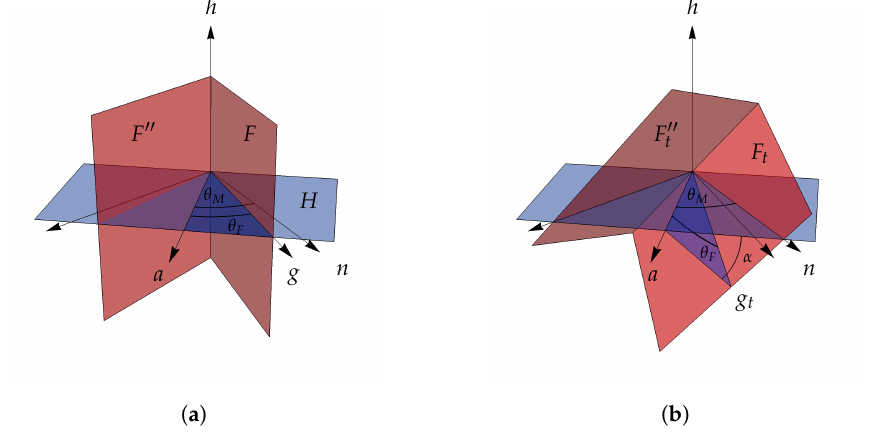
Figure 6. Further illustration of the twist transformation, in the: ( a ) initial; and ( b ) final states. Bivectors F and F (cid:48)(cid:48) with a dihedral angle of 2 θ F rotate around a . Vector g is rotated around a down to g t , whereupon θ M between n and a projects in H t to θ F between g t and a . Within the H plane the effective dihedral angle (determined by its intersections with F t and F (cid:48)(cid:48) t ) has expanded from 2 θ F to 2 θ M